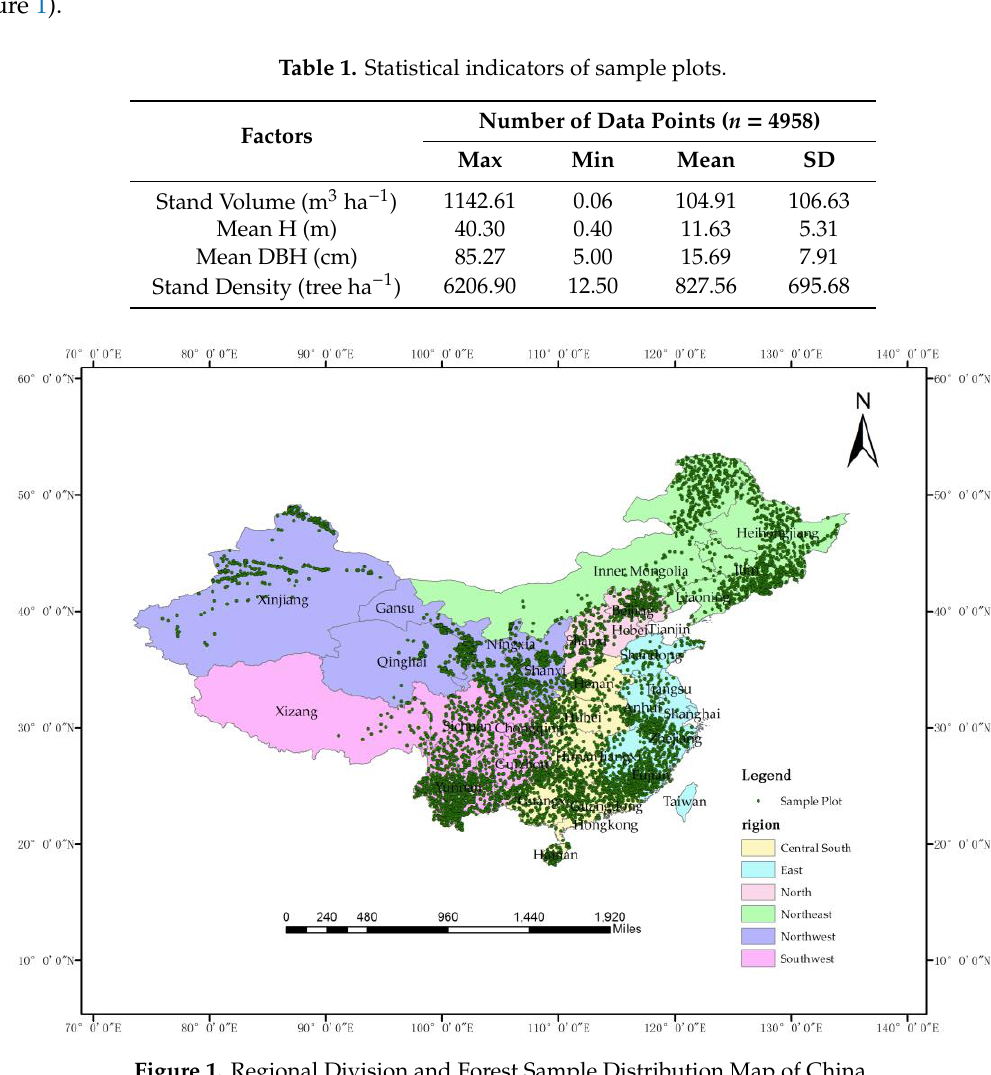
Figure 1. Regional Division and Forest Sample Distribution Map of China.